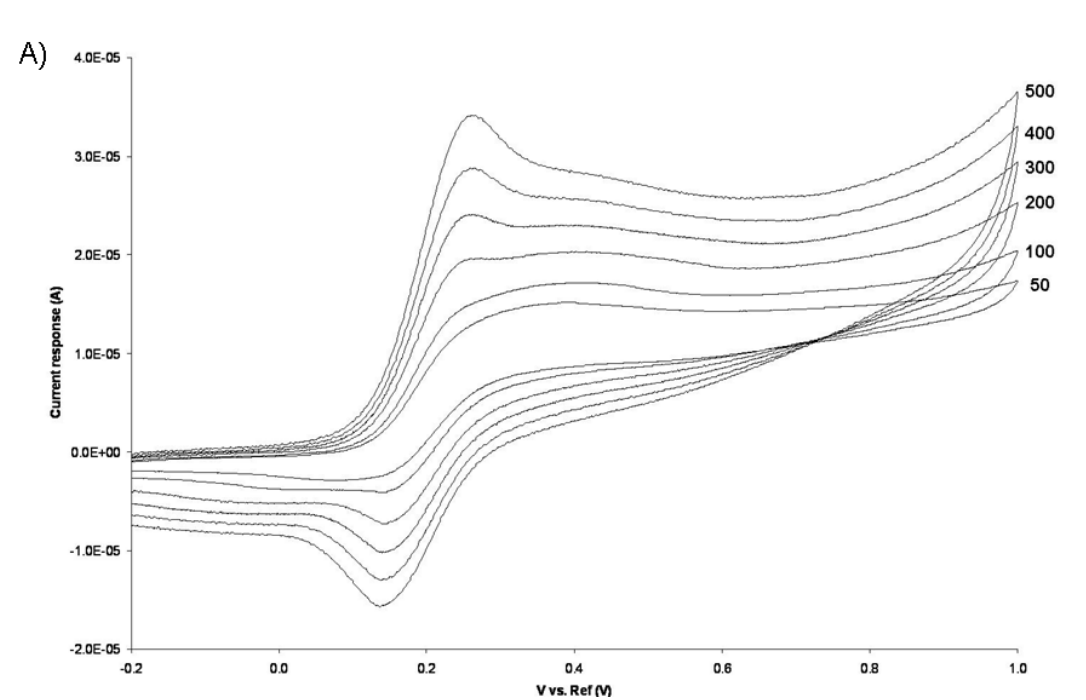
Figure 7. Typical cyclic voltammetric behavior of a single 3D Au/PPy microelectrode, using a Ag/AgCl (3M KCl) reference electrode and a Pt wire counter electrode, obtained in (A) a 10 mM Ferrocyanide aqueous solution in PBS (pH 7.4) where the voltage is